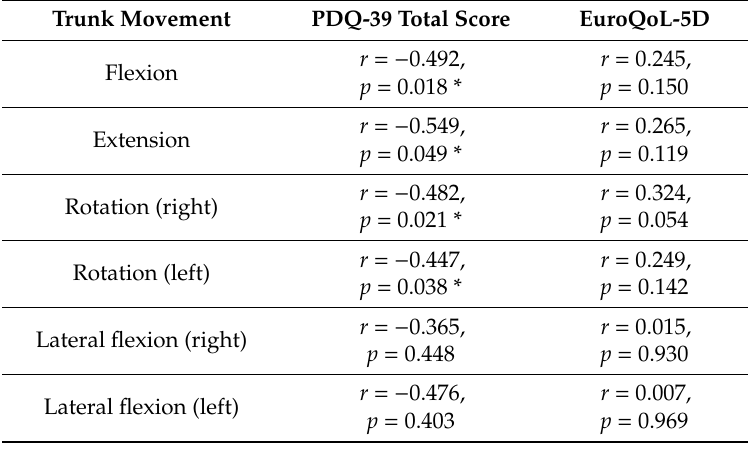
Table 4. Correlations between trunk ROM and